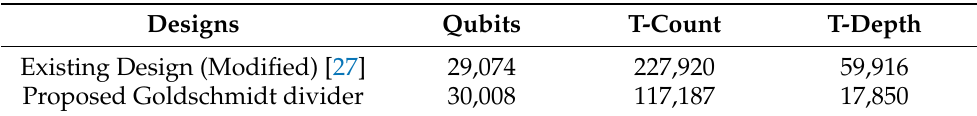
Table 6. Comparison of proposed single-precision Goldschmidt floating-point division quantum circuits with the existing